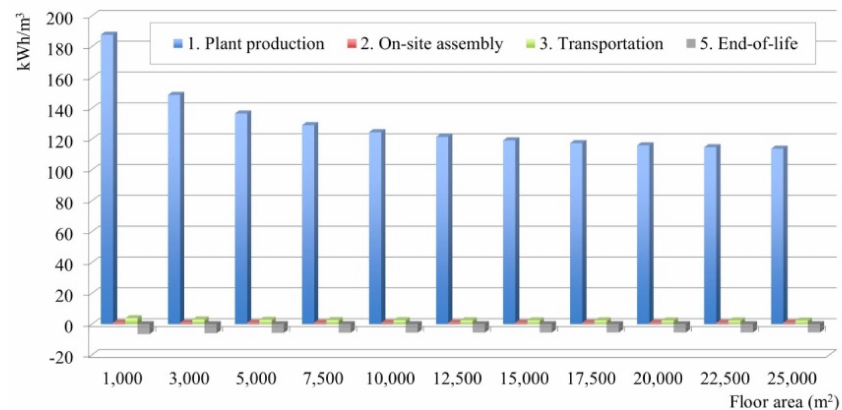
Figure 7. EF (reference scenario) as a function of the floor area. The use phase (not shown) is constant (463.93 kWh/m 3 ).